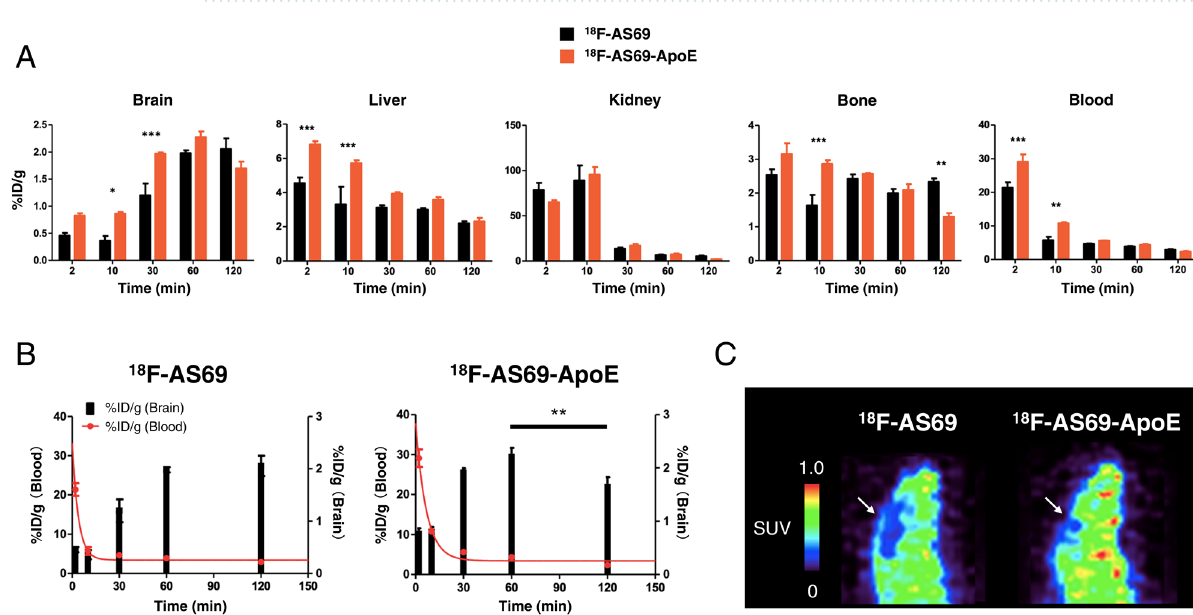
Figure 4. Ex vivo and PET biodistribution study in mice using 18 F-AS69 and 18 F-AS69-ApoE. (A) Normalised radioactivity [percentage of injected dose/g (%ID/g)] from the mouse brain at each time point [ 18 F-AS69- ApoE: 2 and 10 min (n = 3); 18 F-AS69: 10, 30 and 120 min; 18 F-AS69-ApoE: 30 min (n = 4); 18 F-AS69-ApoE: 120 min (n = 5); 18 F-AS69: 2 and 60 min; 18 F-AS69-ApoE: 60 min (n = 7)]. The black and orange bars indicate the %ID/g value ± SEM in mice administered 18 F-AS69 and 18 F-AS69-ApoE, respectively. The injected dose in all experiments ranged from 185–370 kBq. Statistical significance was calculated using two-way ANOVA and Sidak’s multiple comparisons test (* p < 0.05, ** p < 0.01, and *** p < 0.001). (B) Comparison of time–activity curves in the brain and blood following the administration of 18 F-AS69 and 18 F-AS69-ApoE. The values of %ID/g in the blood (red dot) were fitted to a one-phase decay model, and the curve (red) was drawn. Black bars indicate the %ID/g value ± SEM. Statistical analysis was performed using two-way ANOVA and Sidak’s multiple comparisons test (** p < 0.01). (C) PET images with 18 F-AS69 and 18 F-AS69-ApoE in the mouse brain (25–30 min post-injection, sagittal views). White arrows indicate the position of the mouse